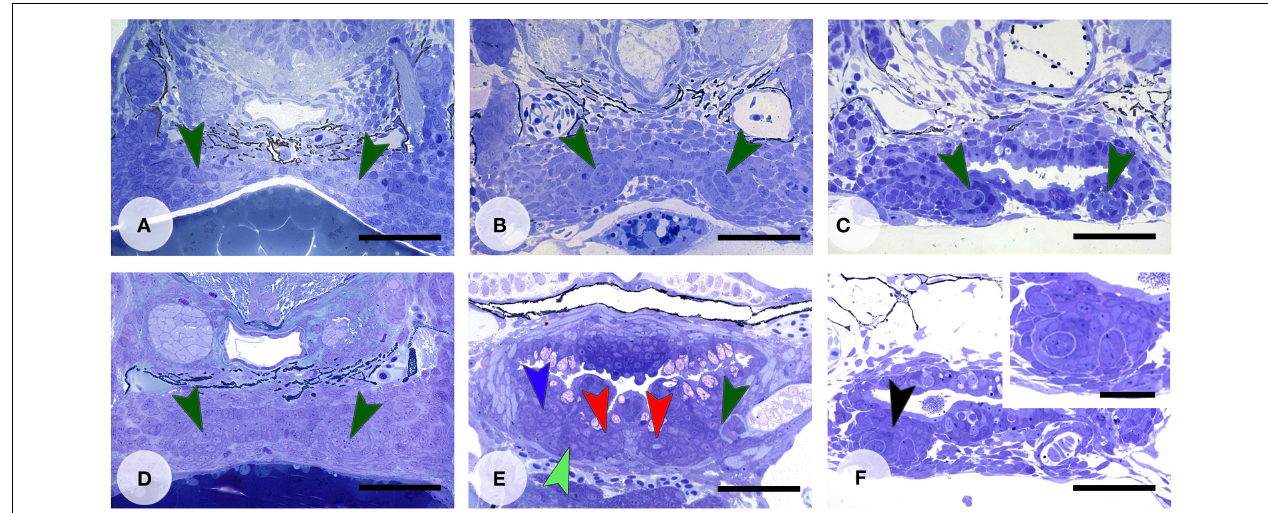
FIGURE 5 | Enhanced Wnt signaling through LiCl treatment. Dentition of control zebrafish at start of treatment at 45hpf (A) , and treated with 300mM LiCl for 1h ( B , fixed at 60hpf and C , fixed at 112hpf). In (B,C) only tooth 4V 1 is present. Dentition of control zebrafish at start of treatment at 72hpf (D) , and treated with 300mM LiCl for 1h ( E , fixed at 92hpf), or treated with 300mM LiCl for 10min ( F , fixed at 112hpf).